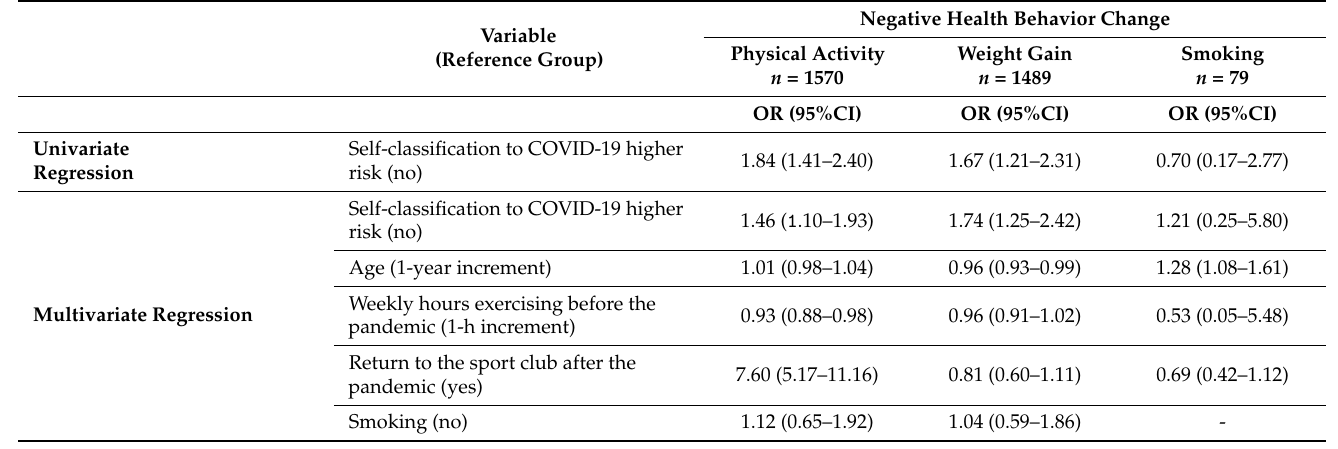
Table 3. Logistic regression models for factors associated with negative health behavior changes (yes/no) from the beginning of the COVID-19 outbreak in March until the beginning of August 2020 among physically active elderly members of the health club